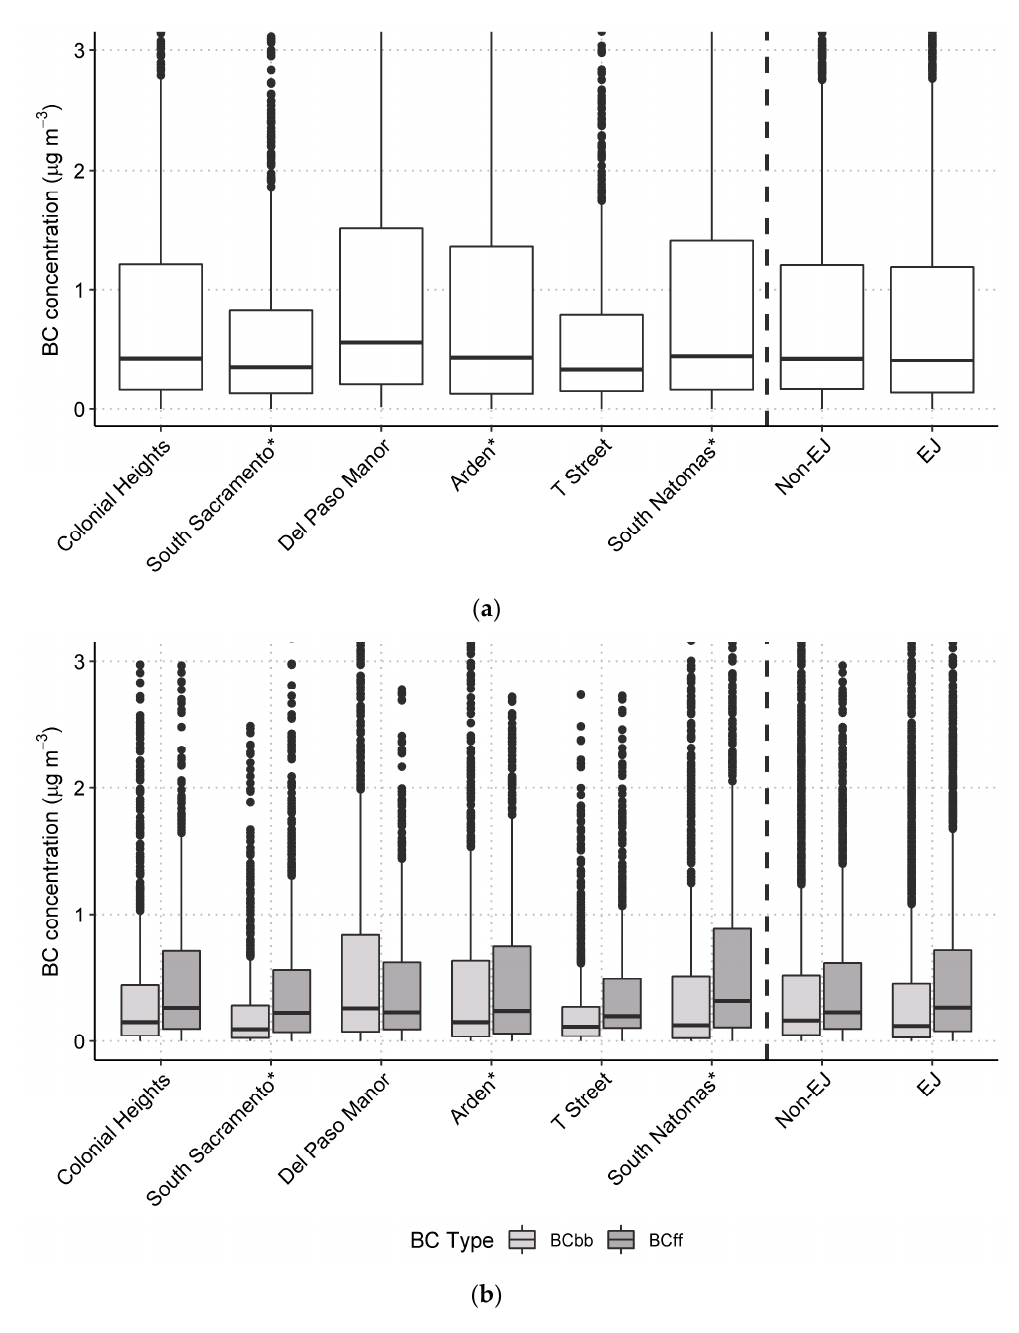
Figure 5. Notched box plot of concentrations by site and for all EJ and all non-EJ sites, from December 2016 through January 2017 for ( a ) BC and ( b ) BC wb and BC ff . Data values above 3.1 µg/m 3 are not shown. * Indicates an EJ site. Boxes are the interquartile range (IQR), and the notch is the median and 95% confidence interval about the median; the whiskers go to 1.5 × IQR, and data beyond this are shown as individual points.